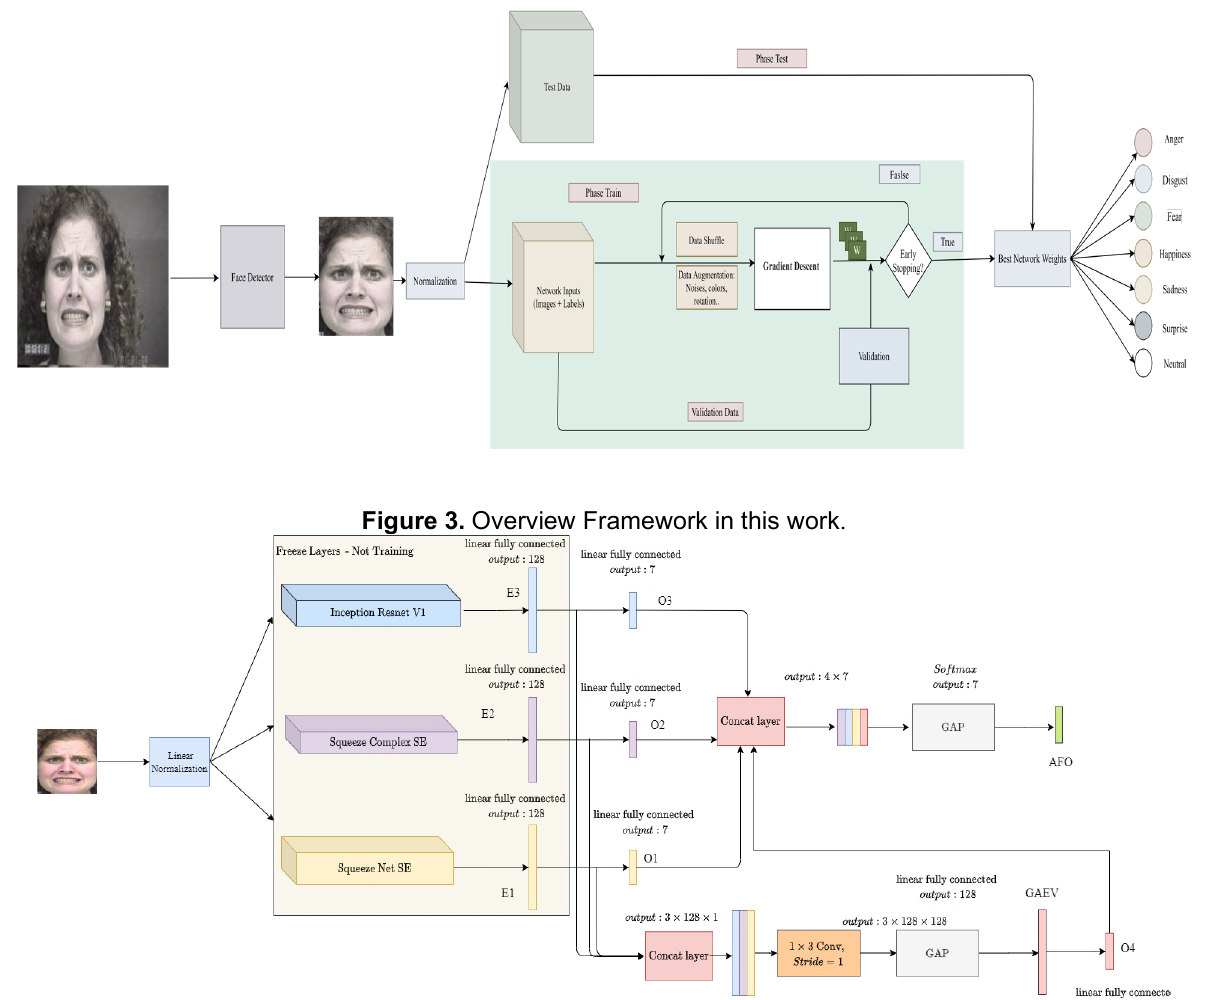
Figure 4. Ensemble model architecture proposed in this work